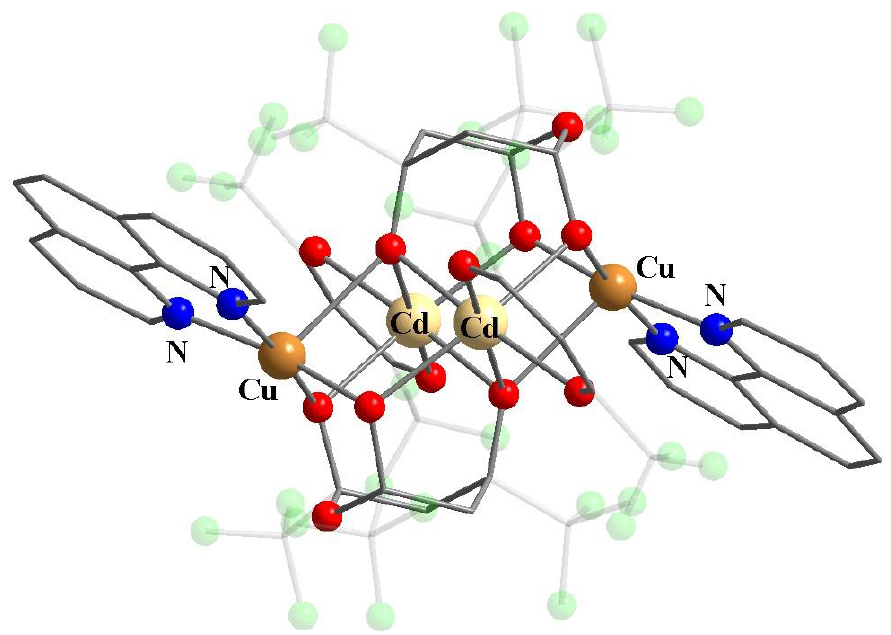
Figure 40. The crystal structures of [Cu 2 (phen) 2 (ttpt) 2 Cd 2 (hfac) 2 ] ( 91 ) [129]. CF 3 groups are transpar- ent for clarity. The cif has been retrieved from CCDC. CCDC number is 616292.